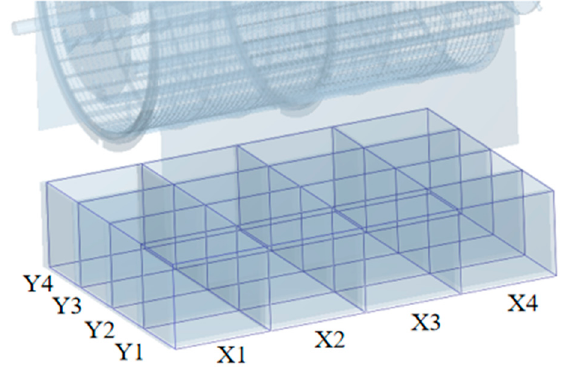
Figure 12. Grid bin group 2.